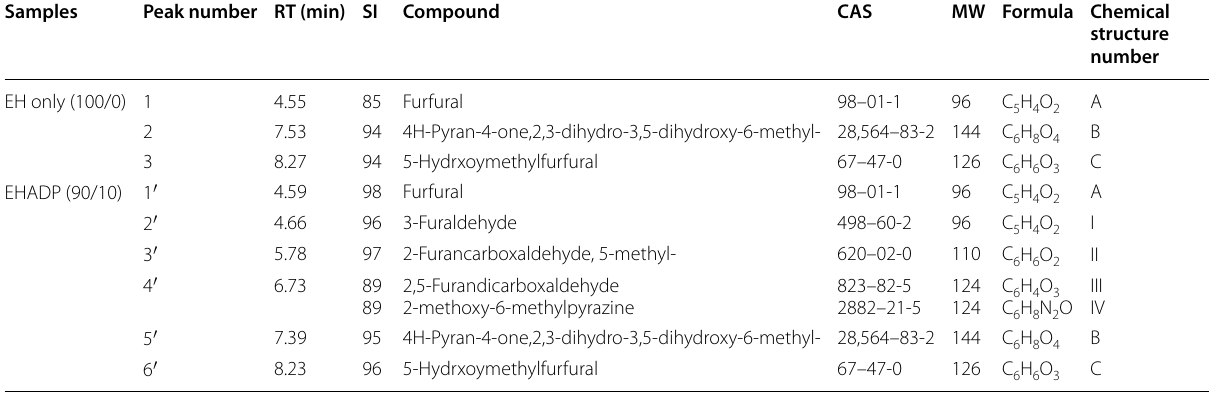
Table 2 Identified chemical compounds in evolved gas derived from uncured EH and EHADP adhesive heated at 170 °C for 60 s